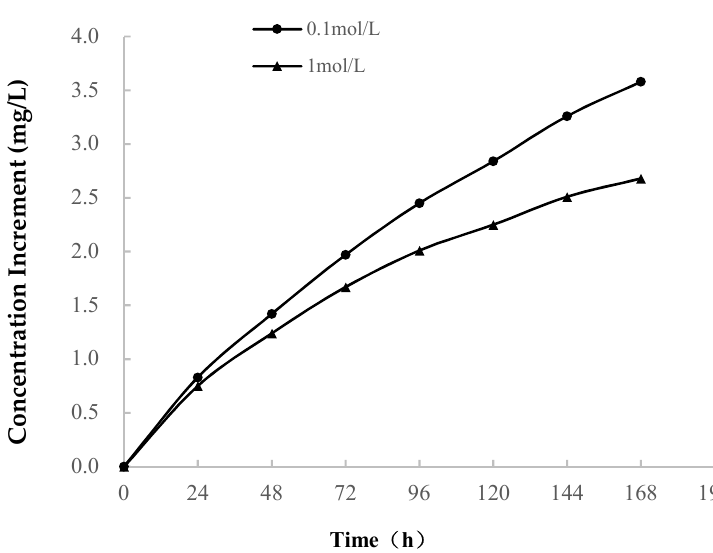
Figure 9. The Ca 2 + concentration increase curve for the CaCl 2 Figure 9. The Ca 2+ concentration increase curve for the CaCl 2 solution.